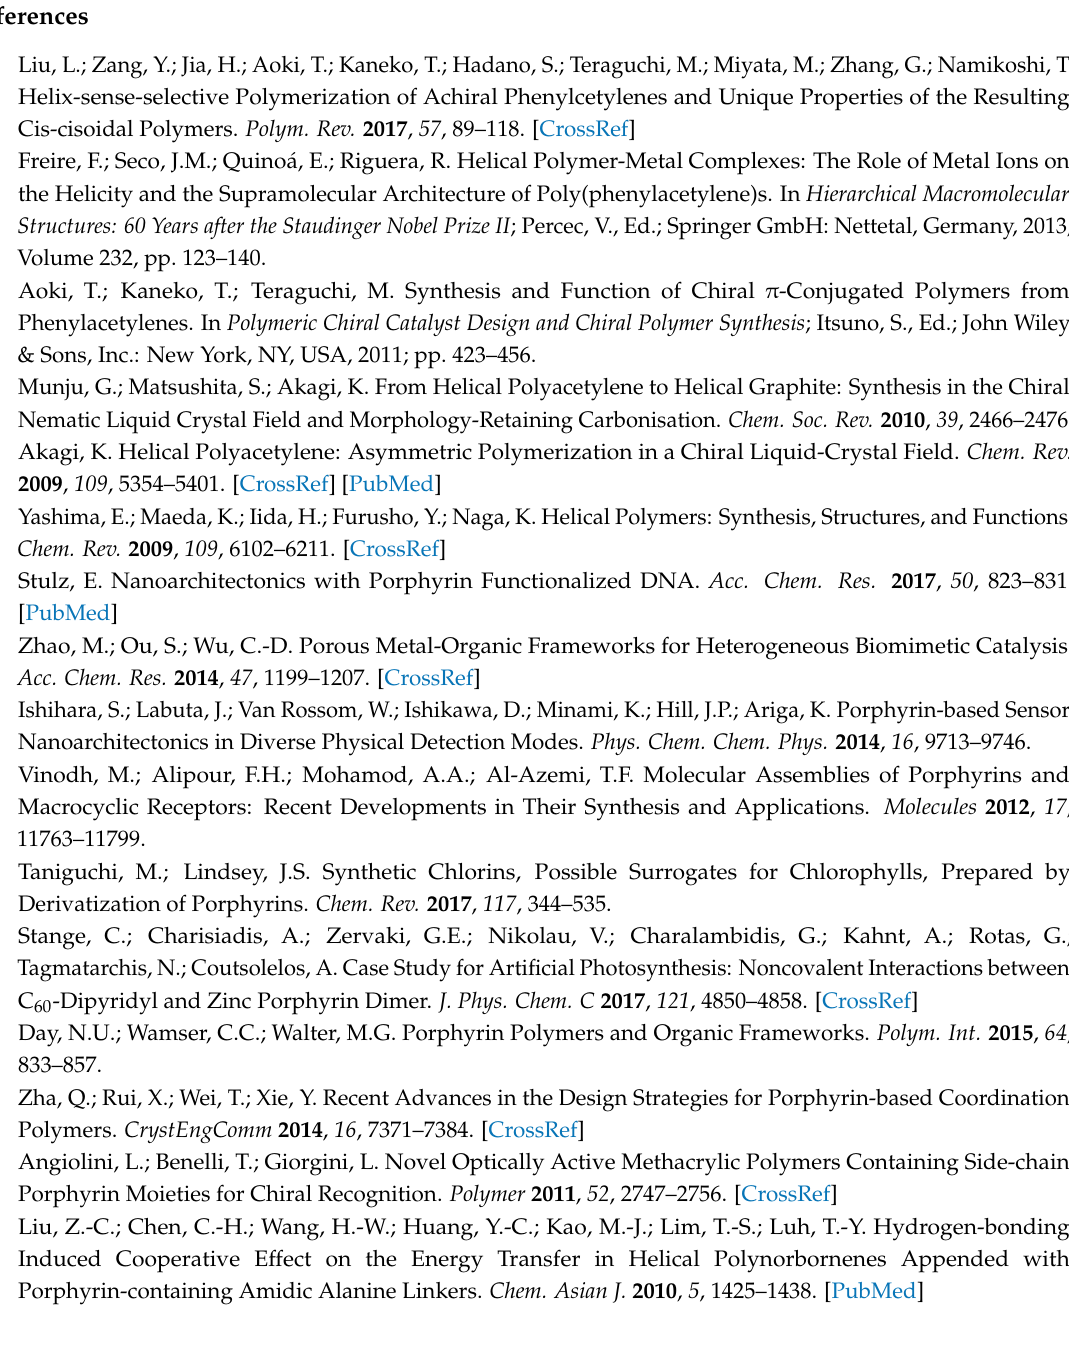
Figure S1, IR spectra of poly( 1 ) in THF/HMPA at room temperature. Figure S2, CD and UV-vis spectra of poly(DoDHPA) in THF/HMPA at room temperature. Figure S3, UV-vis spectra of 1 and poly( 1 ) in THF at 20 ◦ C (cell length = 10 mm)( c = 0.0005 mM). Figure S4, UV-vis spectra of Zn1 and poly( Zn1 ) in THF at 20 ◦ C (cell length = 10 mm) ( c = 0.0005 mM). 1 H NMR spectra of monomer and intermediates, and mass spectrum of 1